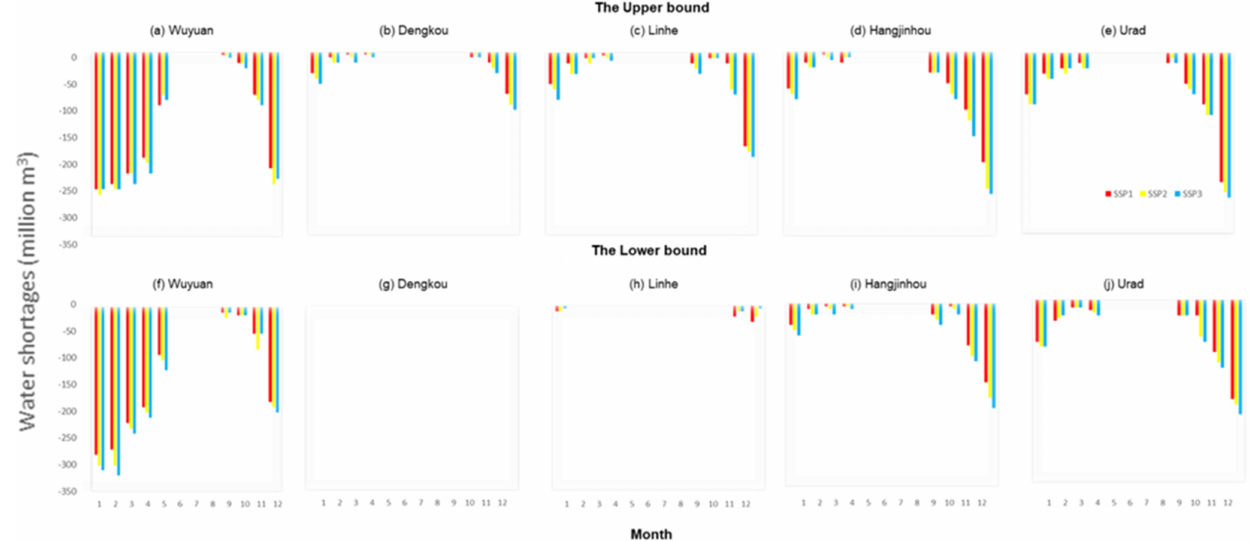
Figure 5. Average monthly water shortage in five areas of the Hetao Irrigation District from 2010 to 2050